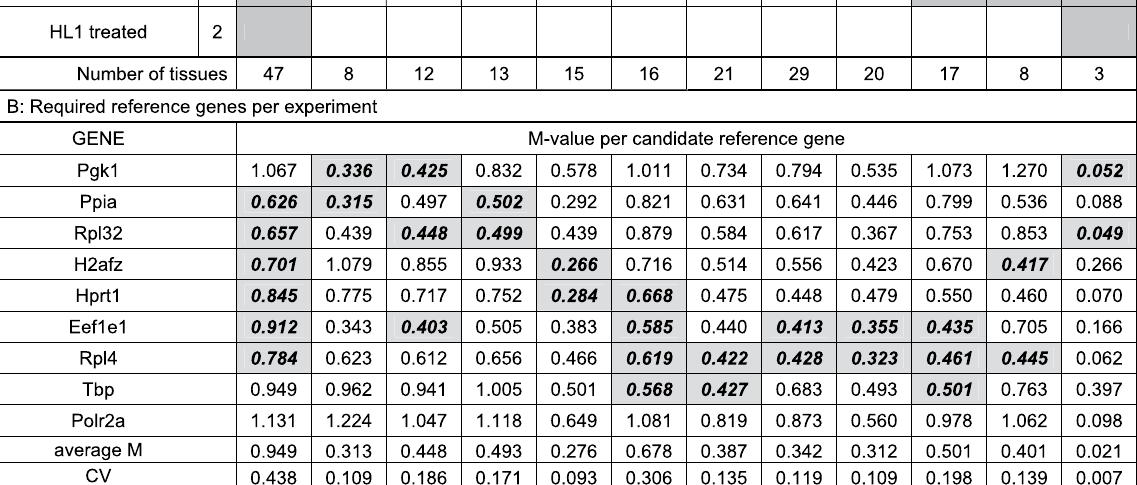
protein Actb changes during heart development and failure 9 . Moreover, the large number of pseudogenes in the mouse genome negatively affects the reliability of Gapdh and Actb as reference genes when the PCR primers are not selected properly and the sample is contaminated with genomic DNA 10 . These issues indicate that the choice of reference genes should not just be based on the similarity of the exper- imental design to earlier studies; reference gene stability should be determined in an experiment in which the stability of a set of candidate genes is tested in the full range of experimental conditions that are applied in the current study 3 .